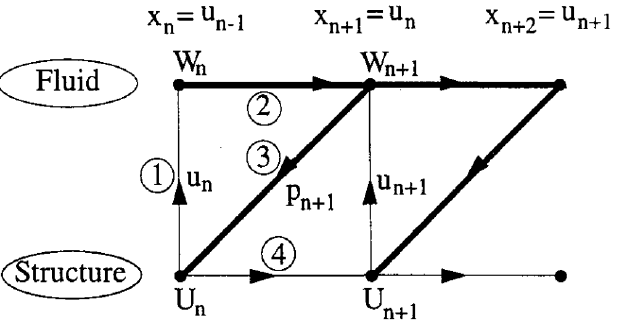
Figure 9. Conventional serial staggered algorithm. The circled numbers indicate steps